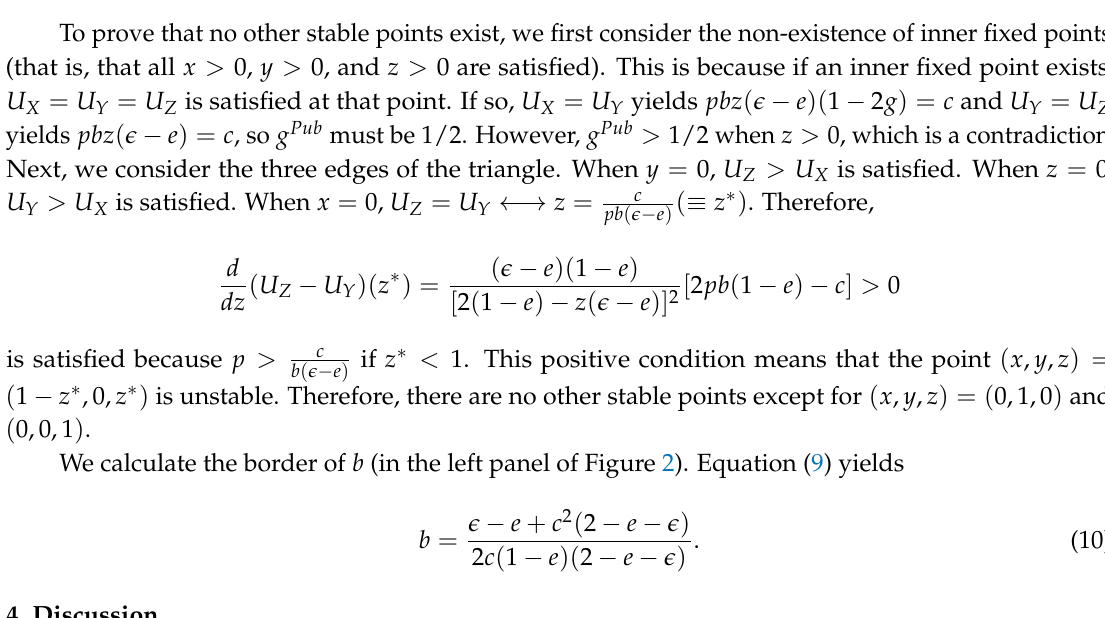
Figure 2. Phase transitions of p . The panels show parameter spaces in which the stern-judging rule is stable. The vertical axis shows p while the horizontal axis shows b (in the left panel, with e (cid:48) = 5% and e = 5%), e (cid:48) (in the center panel, with b = 3 and e = 5%), and e (in the right panel, with b = 3 and e = 5%). The borders of the yellow basin are b = 1.16 in the left panel and e = 0.33 in the right panel. The other parameter value is c =